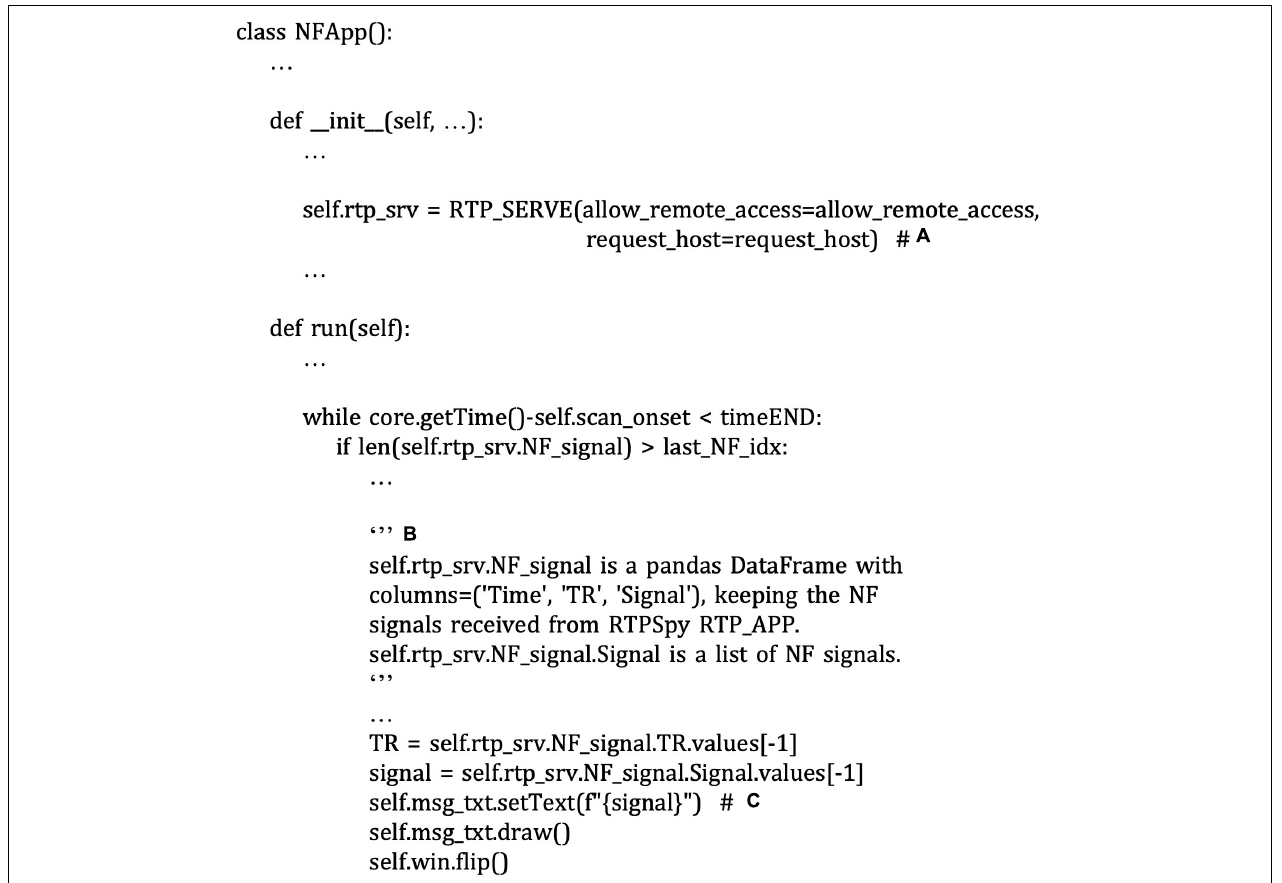
FIGURE 11 | A snippet of an example script of neurofeedback presentation application in the “ example/ROI-NF/NF_psypy.py ” file. The comments with bold alphabet indicate a part of the script explained in the main text. Instantiating the RTP_SERV class object starts a TCP/IP server running in another thread (A) . The RTP_SERVE object holds the received neurofeedback data in the pandas data frame (B) . This example script displays the latest received value on the screen with text (C)